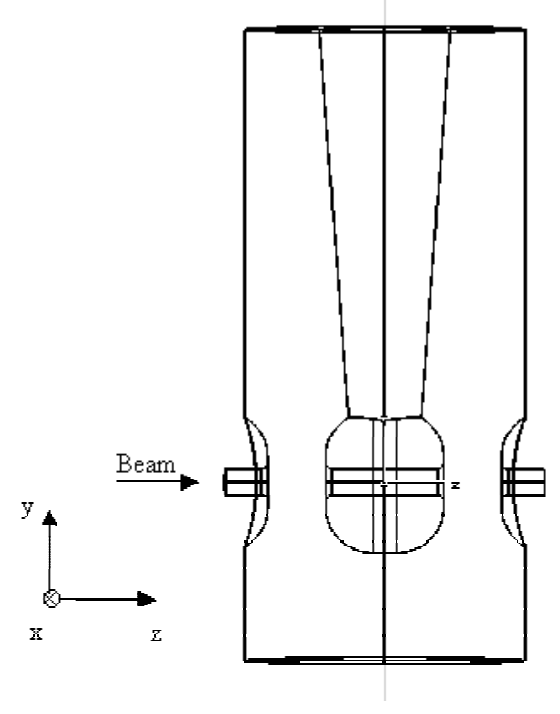
FIG. 1. 115 MHz quarter-wave resonator, b G (cid:1) 0.15 .